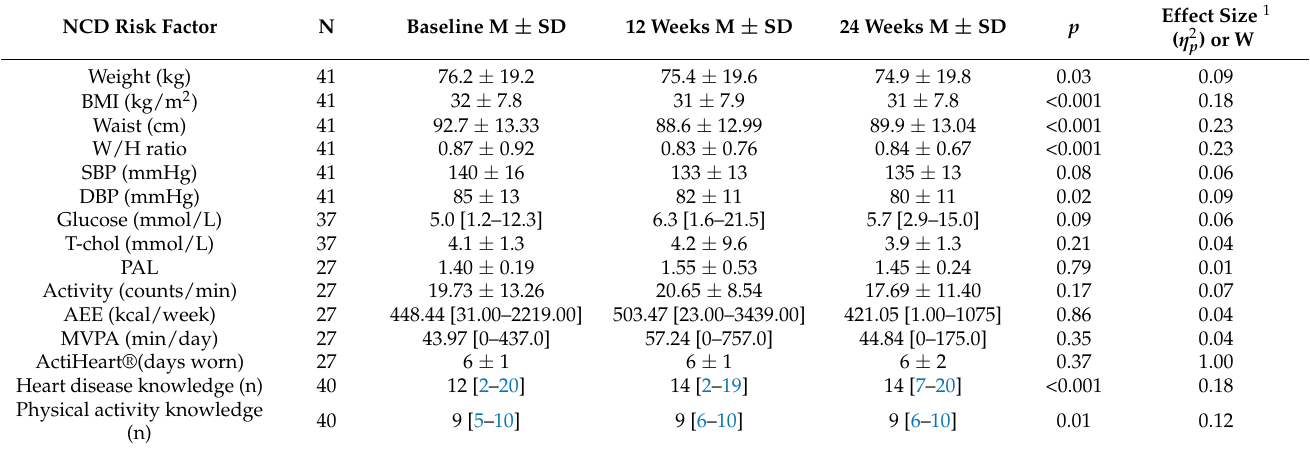
Table 3. Risk factors for non-communicable diseases at baseline, 12 weeks, and 24 weeks of supervised exercise in a low-resourced